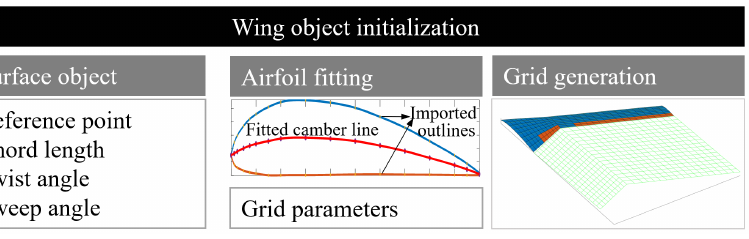
Figure 4. The process of geometry discretization of a wing